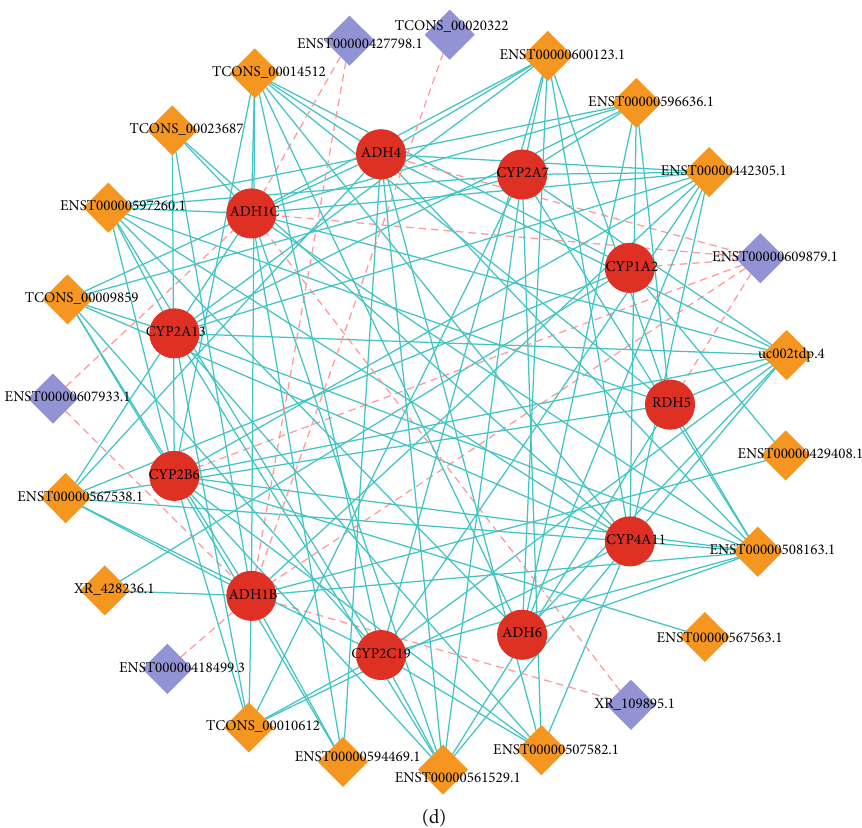
Figure 5: KEGG pathway analysis and coexpression network. (a) Dot plot of the top 10 enriched KEGG pathways of upregulated or downregulated genes. The logFC of DEGs obtained from di ff erential expression analysis was applied for enrichment analysis. (b) The mountain range of the top 10 enriched KEGG pathways of upregulated or downregulated genes. (c) Cnetplot of the correlation between metabolism pathways and di ff erentially expressed mRNAs. (d) Coexpression of lncRNA and mRNA network from the retinol metabolism